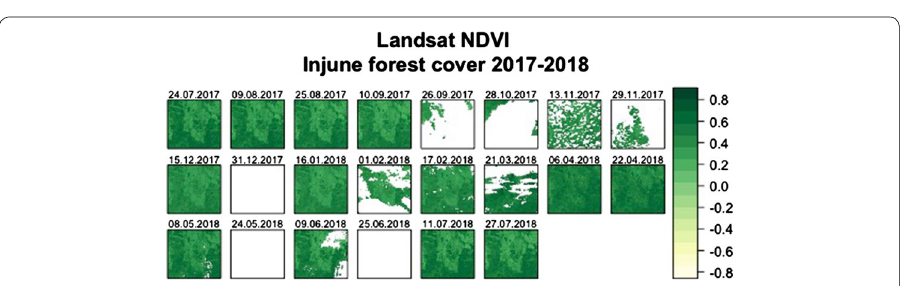
Fig. 2 NDVI of the same area within Landsat 8 images at pixel scale for approximately 1 year. The NDVI values are shown by the scale from light green around 0 to darker green as NDVI approaches 1. White regions indicate the data are missing due to cloud